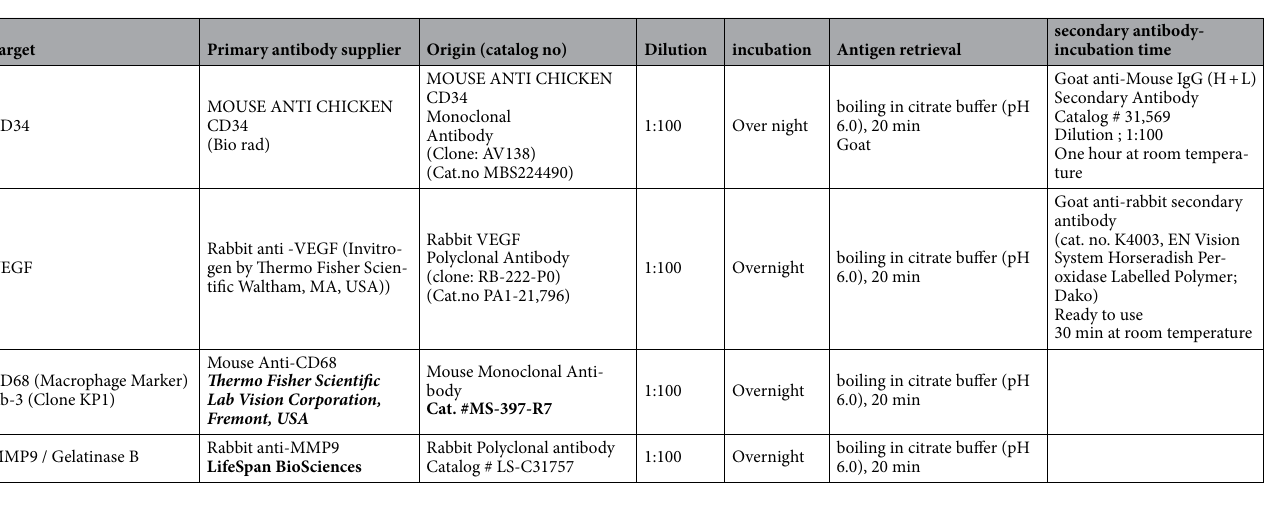
Table 3. Identity, sources, and working dilution of antibodies used in immunohistochemical studies. Antibodies used that showed reactivity in Avian